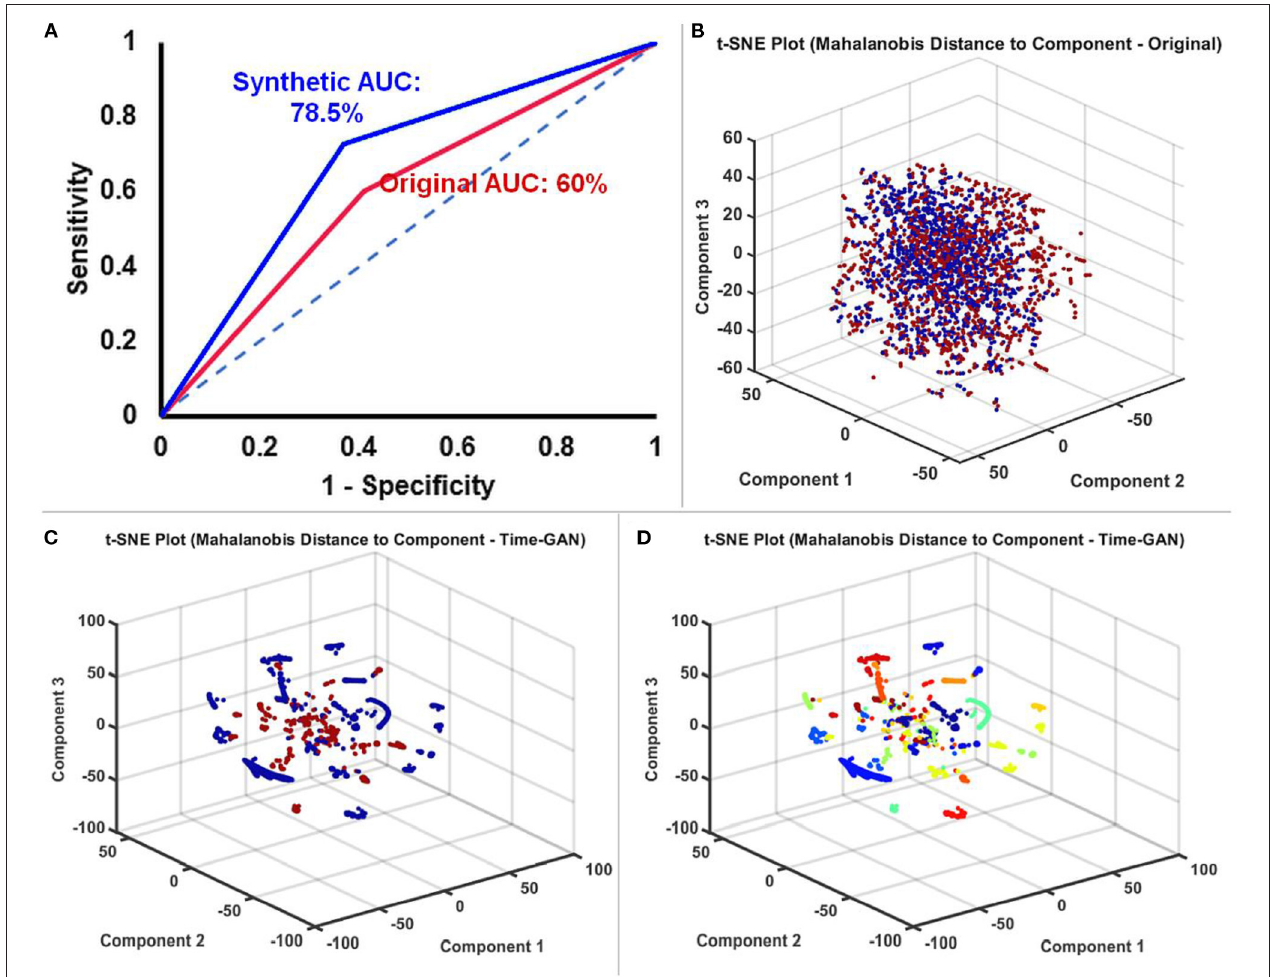
FIGURE 5 | (A) Receiver operator characteristic (ROC) curves comparing the performance of BiLSTM models trained with original and TGAN augmented synthetic data. (B) T-SNE plot of the original SEEG data showing the baseline (red) and ictal (blue) data. (C) T-SNE plot of the TGAN augmented synthetic data shows a clear distinction between the two groups (baseline in red and ictal in blue). (D) A t-SNE indexed by the subject ID showed that TGAN amplifies the ictal data specific to each patient that is distinctly different from their comparable baselines (the different colors are indicative of the data different 13 different subjects). In conjunction with C, we understand that data is not only classified based on ictal and interictal data, but also distinctly clustered based on individual subjects’